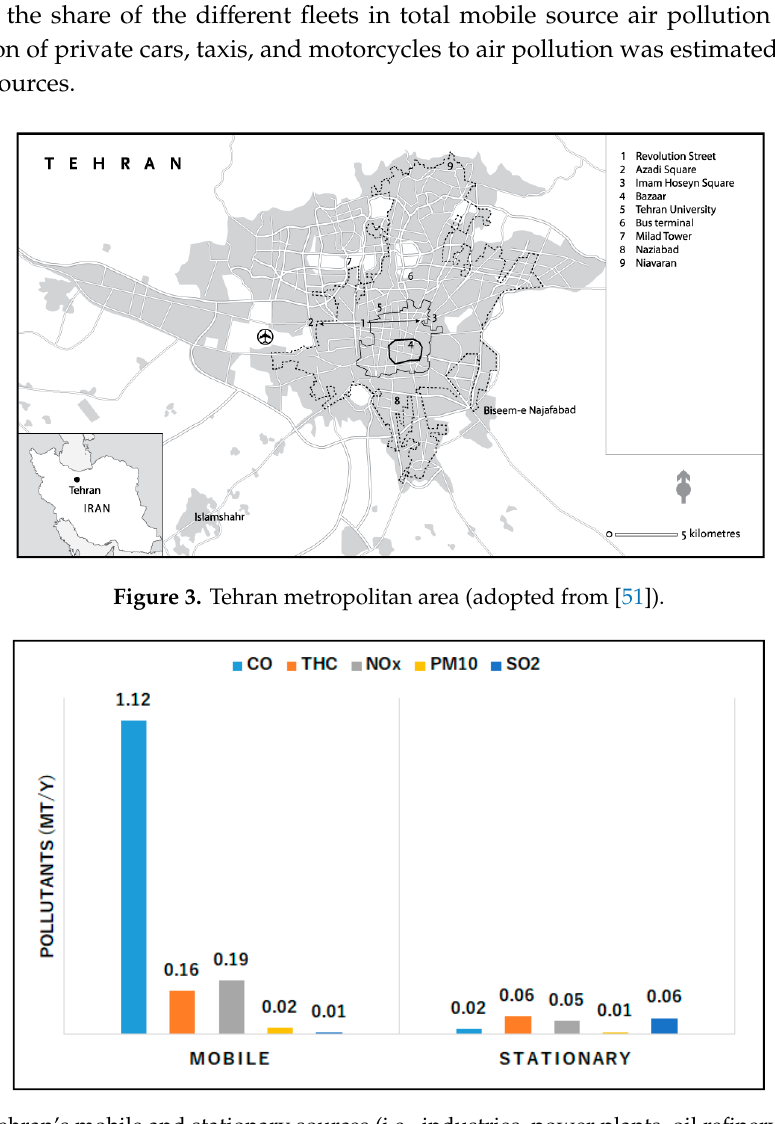
Figure 4. Tehran’s mobile and stationary sources (i.e., industries, power plants, oil refinery, etc.) of air pollution [50].